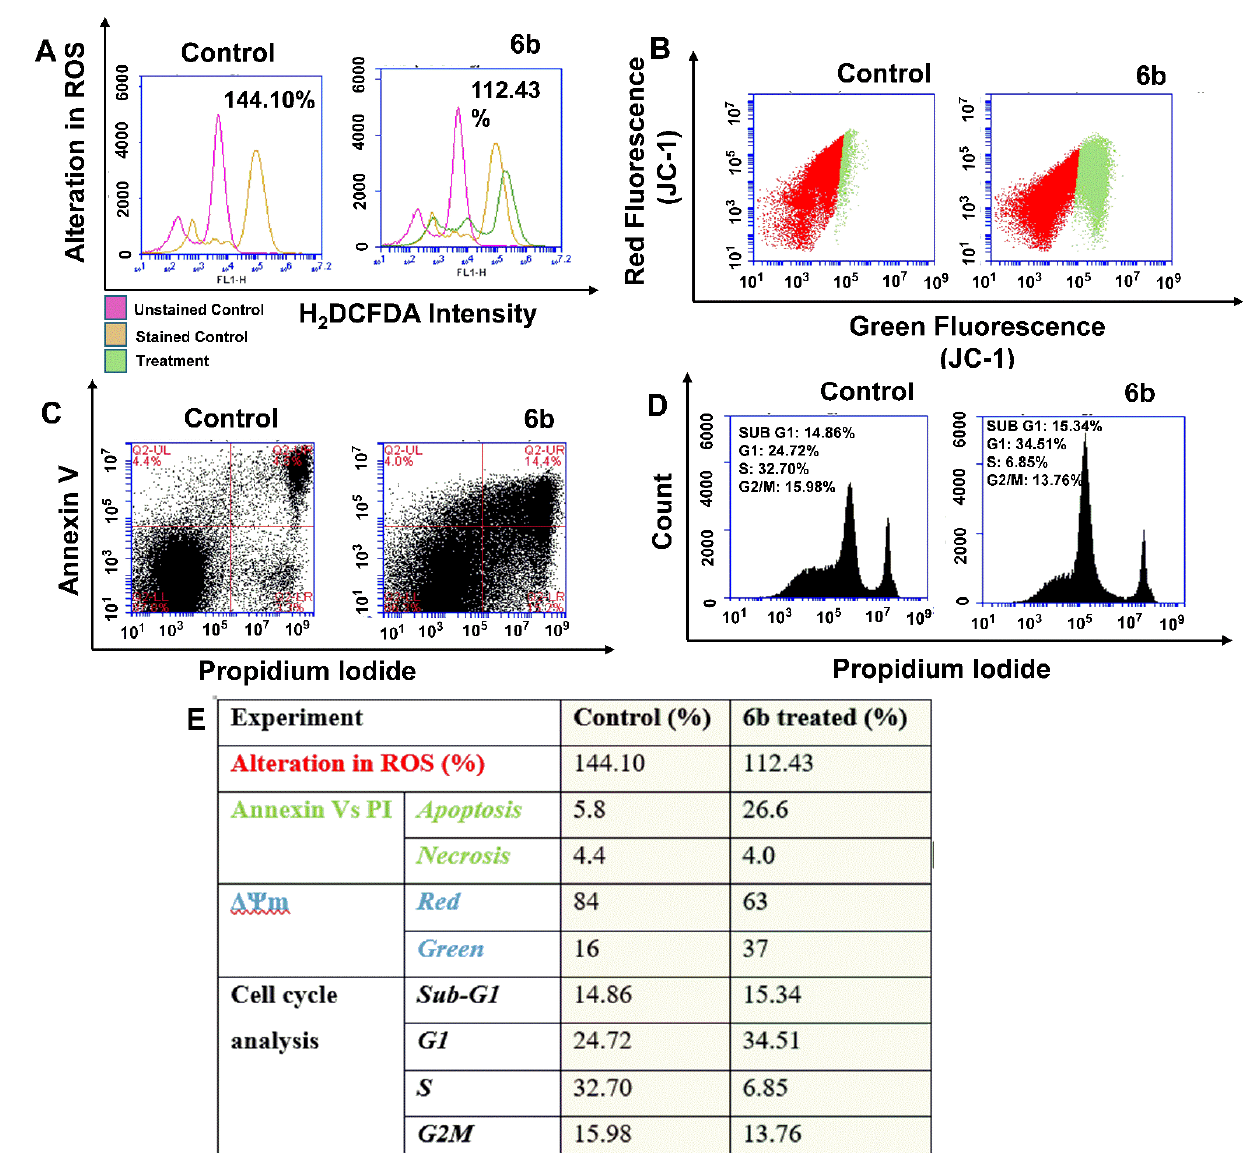
Figure 6. The assays were performed on A549 cells previously treated with investigational compound 6b at sub-IC 50 concentration for 48 h before analysis. Flow cytometry analysis ( A ) suggests alteration in ROS as indicated by H2DCFDA assay; ( B ) shows mitochondrial membrane depolarization (low red/green) as conferred by JC-1 assay; ( C ) depicts an apoptotic mode of cancer cell death as indicated by Annexin V vs. PI assay and ( D ) elaborates cell cycle arrest at G1 phase as indicated by PI assay. ( E ) Table summarizes the quantification values for experiments ( A – D ).